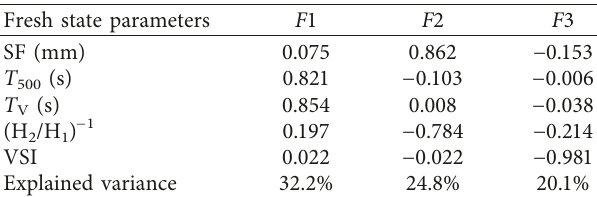
Table 3: Factors extracted by PCA of the fresh state